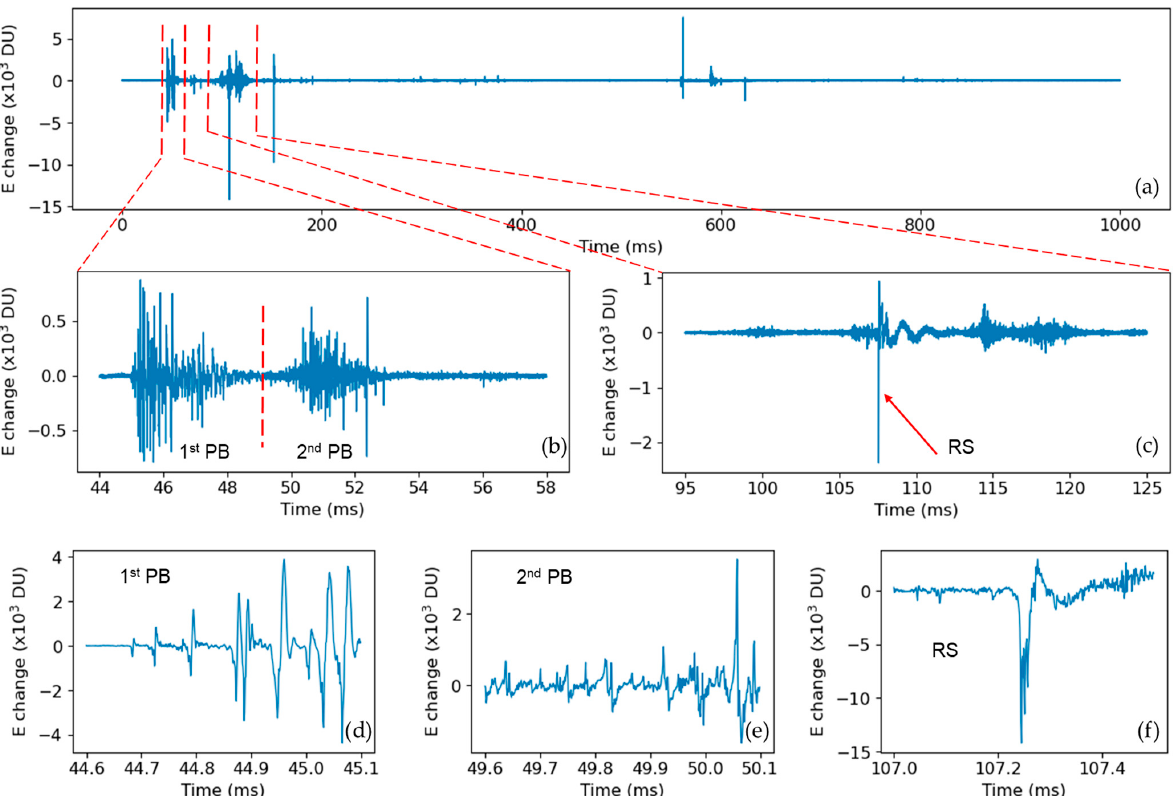
Figure 5. E-field change recorded at one station of FALMA. ( a ) 1 s of waveform; ( b ) waveform from 44 ms to 58 ms including two preliminary breakdowns; ( c ) waveform of the return stroke; ( d – f ) Expanded waveforms to indicate the 1st preliminary breakdown stages and the 2nd preliminary breakdown and return stroke in detail. The “atmospheric electricity” sign convention is used.